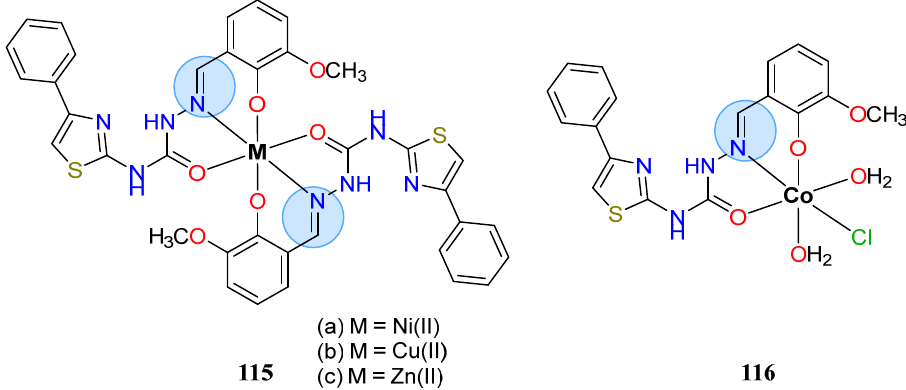
Figure 60. Ni(II) complex with the Schiff base ligand named 2 ‐ (2 ‐ hydroxy ‐ 3 ‐ methoxybenzylidene) ‐ N ‐ (4 ‐ phenylthiazol ‐ 2 yl)hydrazinecarboxamide.